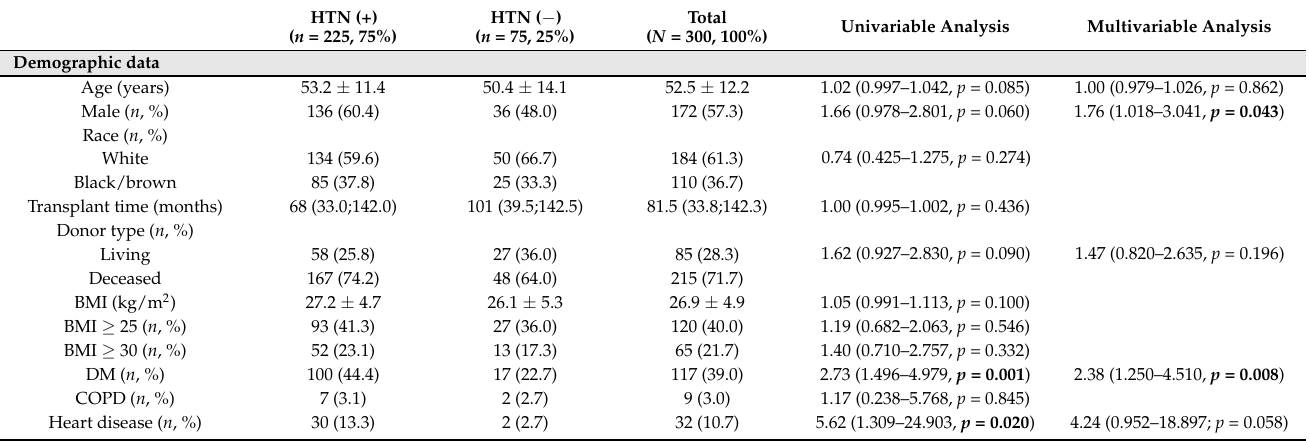
Table 1. Demographic data, laboratory data, and outcomes in kidney transplant recipients according to the presence of hypertension